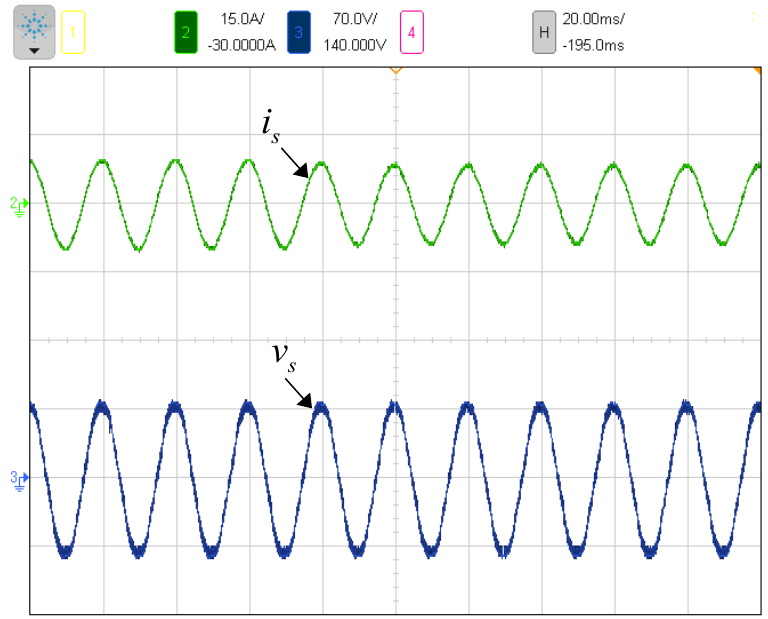
Figure 12. Steady-state experimental results at grid-side variables: Grid current and voltage